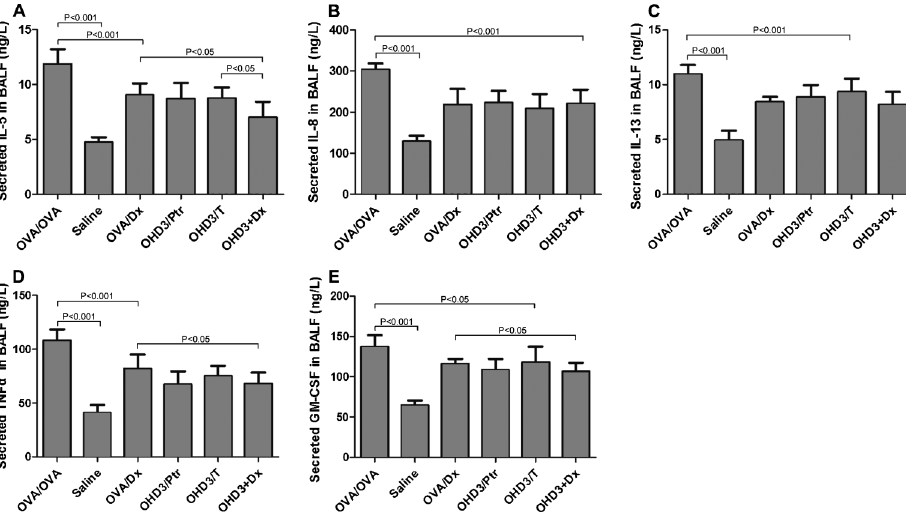
Figure 3. Effects of different treatments on the cytokine release in the bronchoalveolar lavage fluid (BALF). Data are reported as means±SD (n=5/group). The concentrations of all cytokines tested were significantly higher in the OVA/OVA group than in the control group (P , 0.05). The 1,25(OH) 2 D 3 pretreatment and treatment significantly decreased the concentrations of TNF- a , IL-5, IL-13, IL-8 and GM-CSF in the BALF compared to those in the OVA/OVA group (P , 0.05). Among the cytokines measured, the concentrations of IL-5, GM-CSF, TNF- a were lower in the OHD3++Dx group than those in OVA/Dx (P , 0.05). ANOVA and Student-Newman-Keuls tests were used for statistical analyses. Saline: control group; OVA/OVA: asthma group; OVA/Dx: dexamethasone treated group; OHD3/Ptr: 1,25(OH) 2 D 3 pretreatment group; OHD3/T: 1,25(OH) 2 D 3 treated group; OHD3++Dx: dexamethasone and 1,25(OH) 2 D 3 treated group; TNF- a : tumor necrosis factor- a ; IL: interleukin; GM-CSF: granulocyte-macrophage colony-stimulating